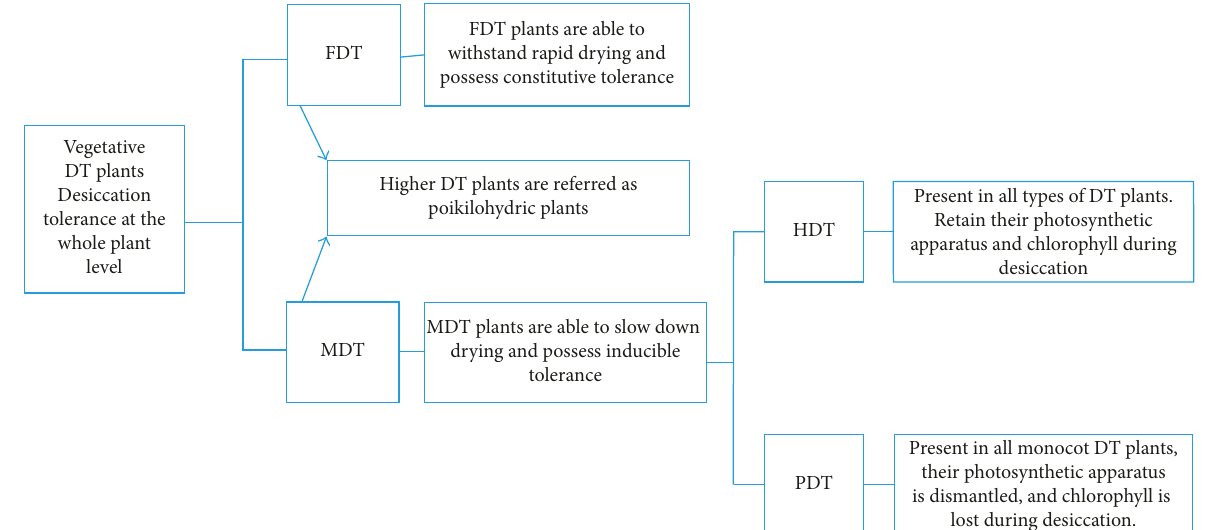
Figure 1: Classification of DT plants according to their stress adaptation